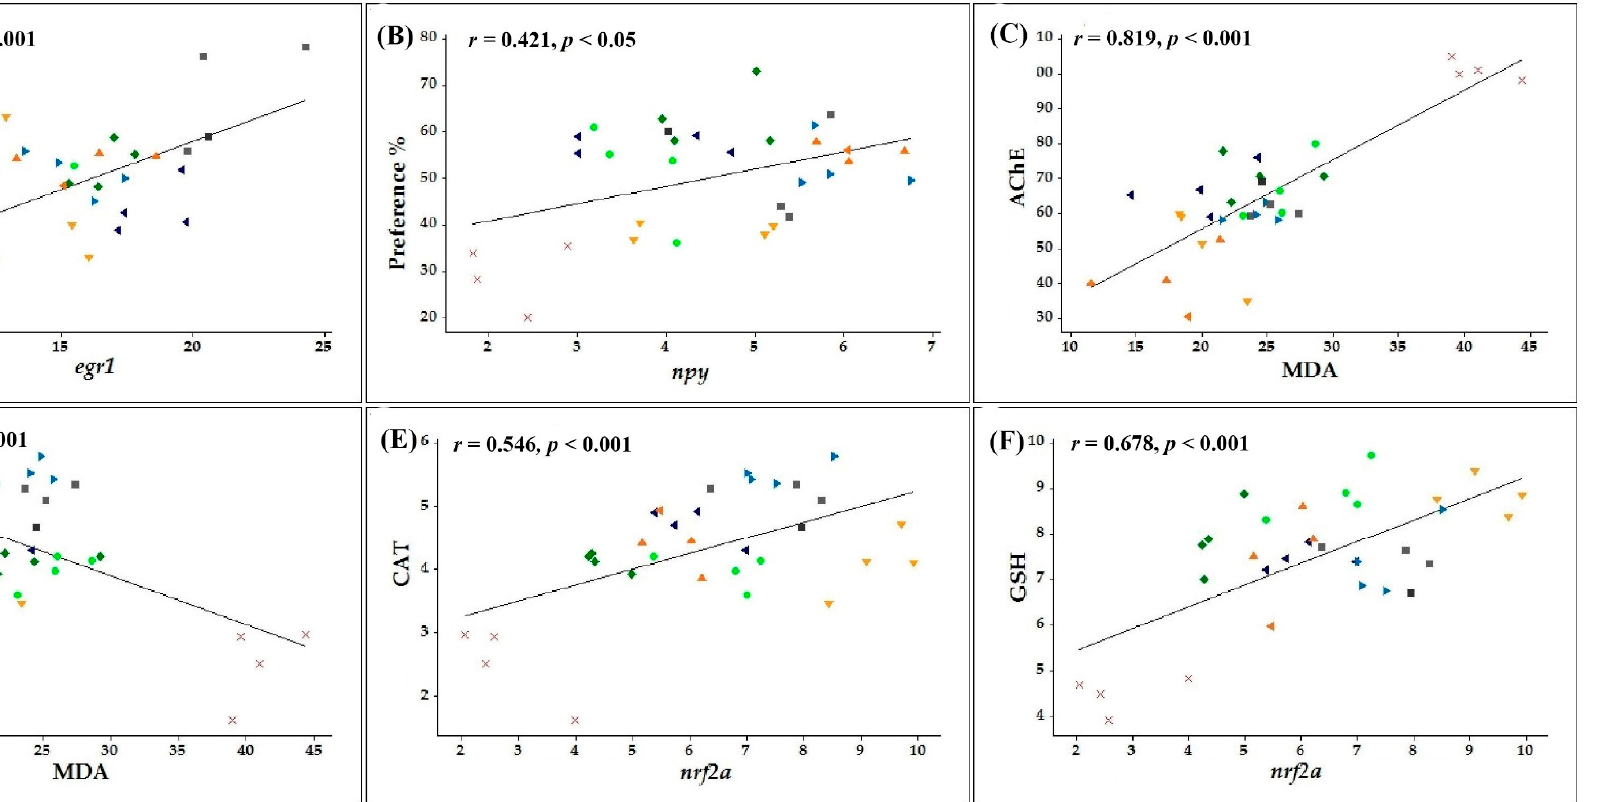
Figure 8. Pearson’s correlation coefficient between behavioral or biochemical parameters and malondialdehyde (MDA) or markers of gene expression (n = 10 animals per group): ( A ) Time in the novel arm (% of total time) vs. early growth response protein 1 ( egr1) ( r = 0.648, p < 0.001), ( B ) Preference % vs. neuropeptide Y (npy) ( r = 0.421, p < 0.05), ( C ) Acetylcholine esterase (AChE) vs. malondialdehyde (MDA) ( r = 0.819, p < 0.001), ( D ) Catalase (CAT) vs. malondialdehyde (MDA) ( r = ‐ 0.613, p < 0.001), ( E ) Catalase (CAT) vs nuclear factor erythroid 2 ‐ related factor 2 ( nrf2a ) ( r = 0.546, p < 0.001) and ( F ) The content of glutathione (GSH) vs. nuclear factor erythroid 2 ‐ related factor 2 ( nrf2a ) ( r = 0.678, p < 0.001) in control ( ■ ), scopolamine (SCOP) ( X ), nicotine (NIC) 1 mg/L + scopolamine (SCOP) ( ▼ ), nicotine (NIC) 2 mg/L + scopolamine (SCOP) ( ▲ ), 6 ‐ hydroxy ‐ L ‐ nicotine (6HLN) 1 mg/L + scopolamine (SCOP) ( ● ), 6 ‐ hydroxy ‐ L ‐ nicotine (6HLN) 2 mg/L + scopolamine (SCOP) ( ♦ ), cotinine (COT) 1 mg/L + scopolamine (SCOP) ( ► ) and cotinine (COT) 2 mg/L + scopolamine (SCOP) ( ◄ ). Data are expressed as follows: AChE (nmol ATCh/min/mg protein), MDA ( μ mol/L), CAT (U/mg protein), GSH ( μ g GSH/ μ g protein), nrf2a (mRNA copy number, ×10,000) and egr1 (mRNA copy number, × 10,000).